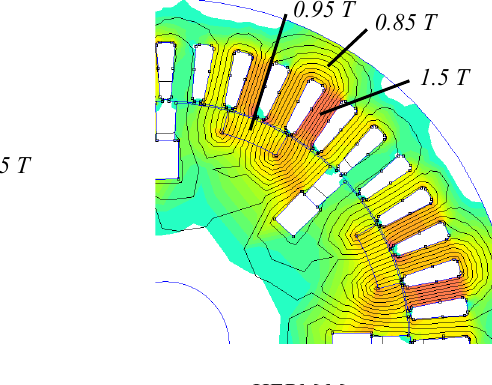
Figure 8. IPM and HEPM motor flux-density in MTPA at 1500 rpm.